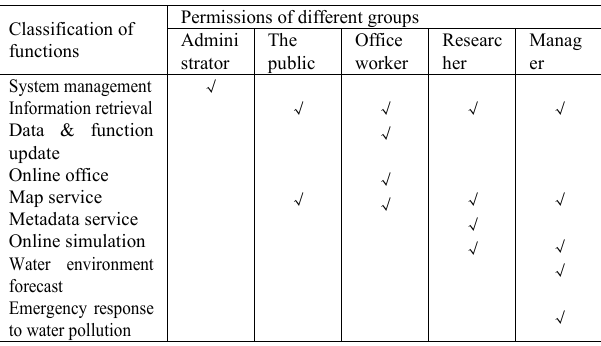
Figure 4. Online hydrological simulation of Huaihe basin